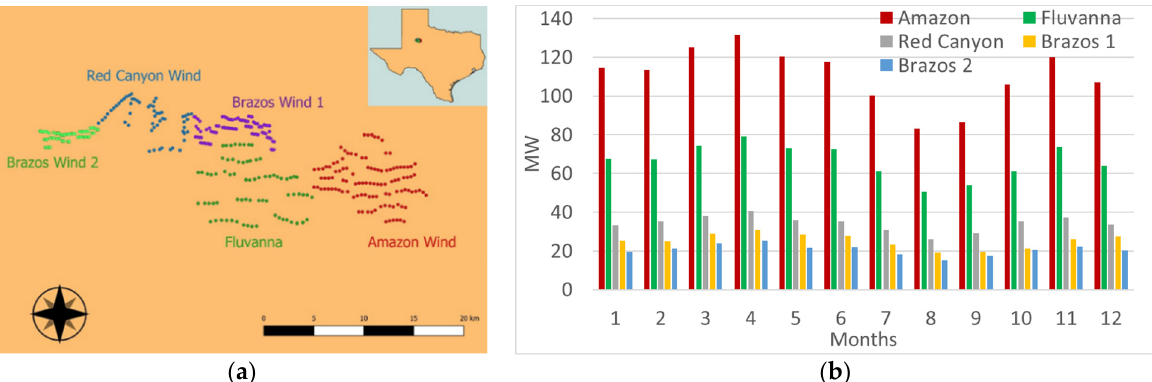
Figure 17. Six wind farms in north west Texas in close proximity to each other. ( a ) Map showing the configuration of the wind farms. ( b ) Monthly average power output in 1980–2018.